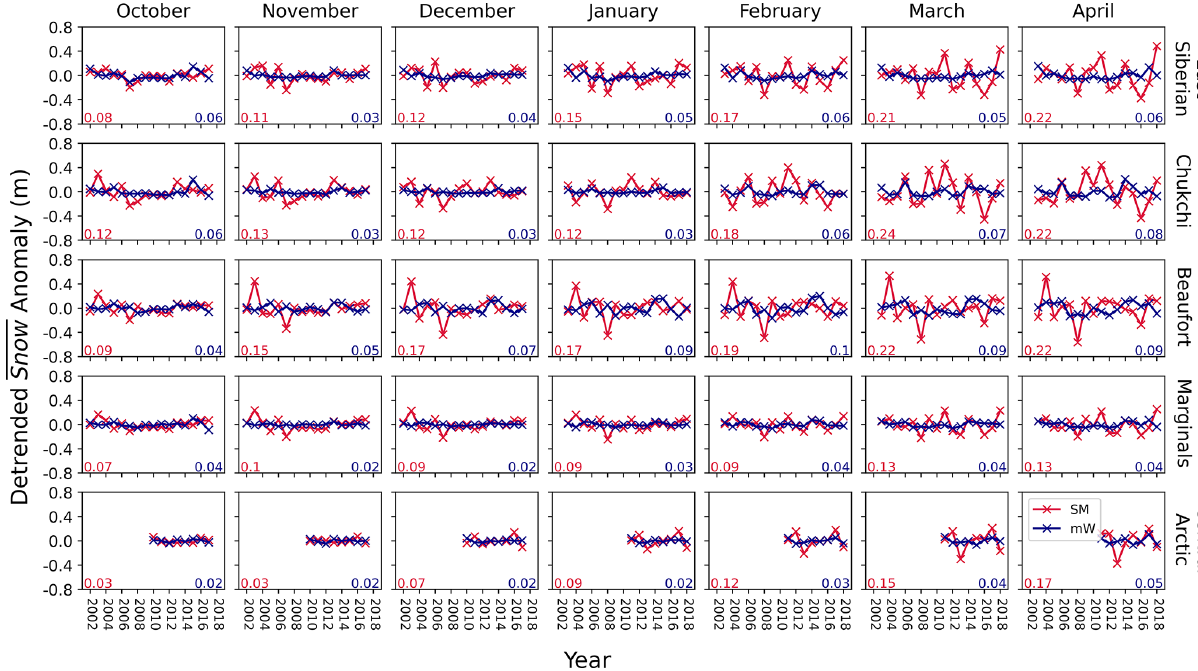
Figure 6. Detrended time series of spatially averaged snow contributions to sea ice thickness (Snow ) by region from W99 (blue) and SnowModel-LG (red). Standard deviation values are displayed for SnowModel-LG (lower left, red) and mW99 (lower right, blue). All regions are plotted in Supplement Fig.